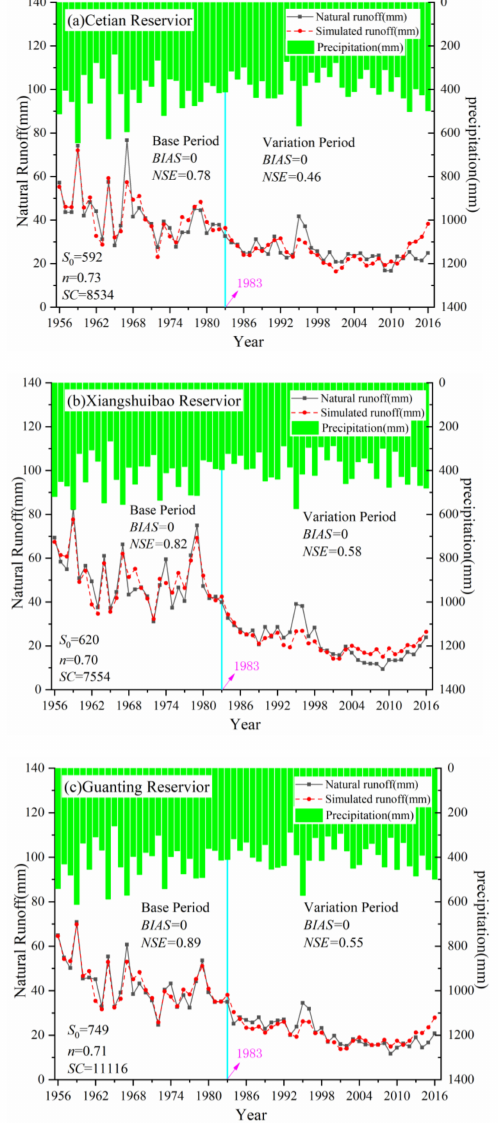
Figure 4. Comparison of natural runoff and WBM-DP simulation value in the mountain area of Yongding River from 1956 to 2016. ( a ) the natural runoff and simulation runoff of Cetian reservior; ( b ) the natural runoff and simulation runoff of Xiangshuibao reservior; ( c ) the natural runoff and simulation runoff of Guanting